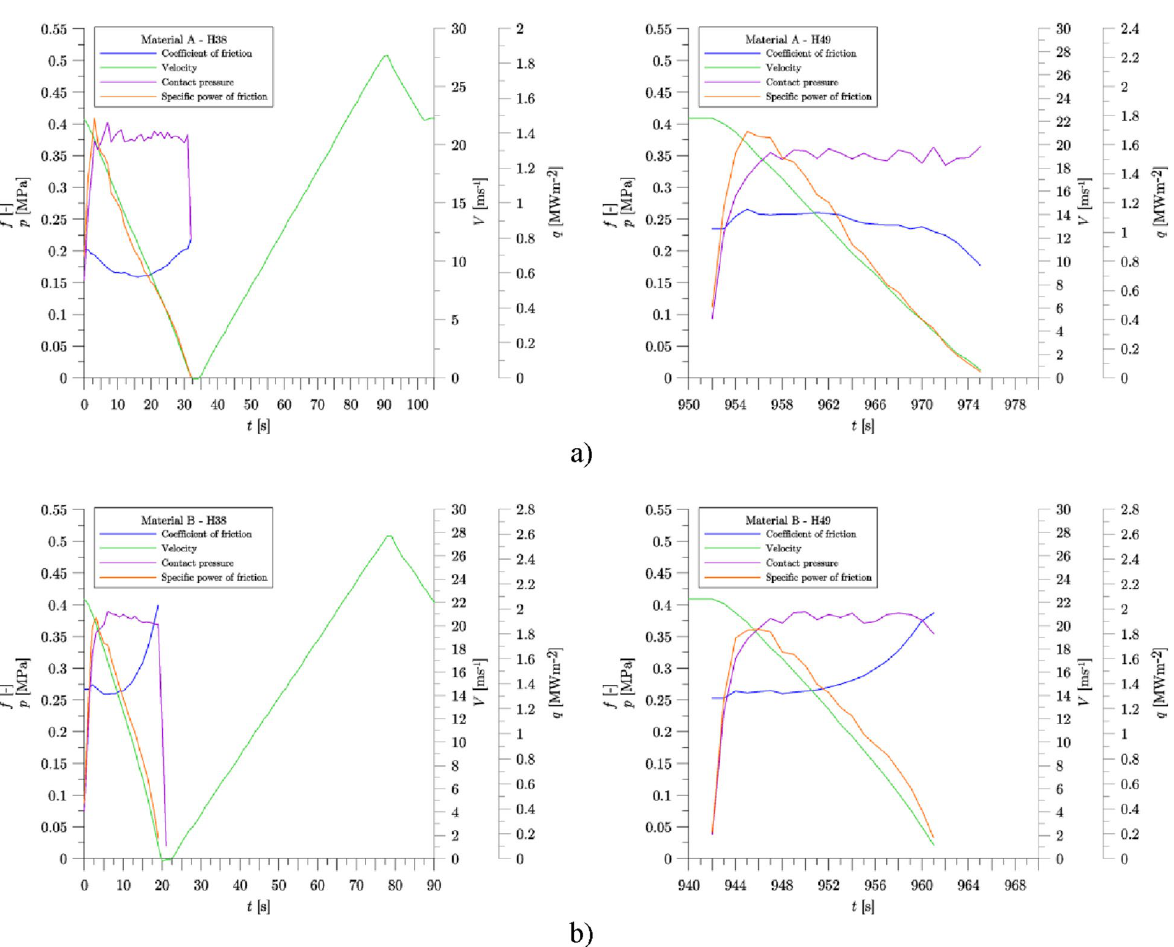
Figure 7. Operating parameters for H38 and H49 brake applications: ( a ) Material A; ( b ) Material